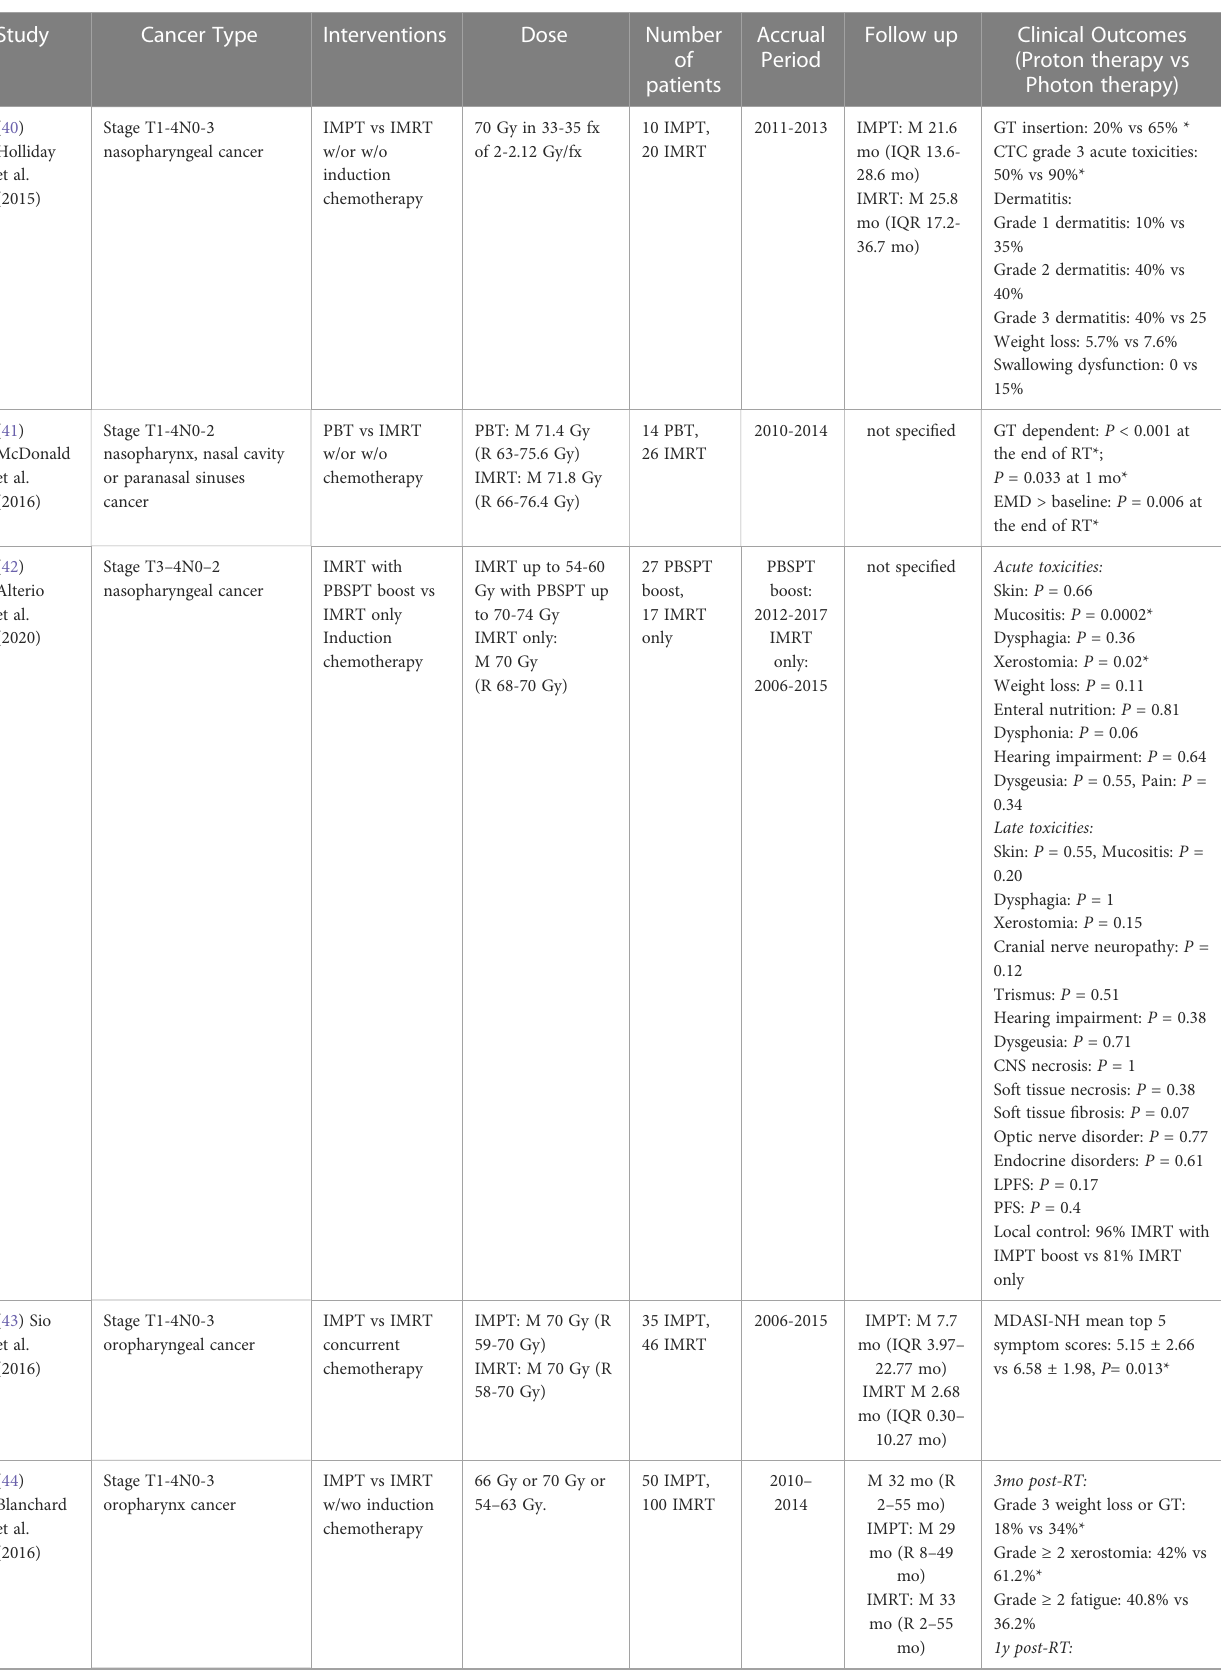
TABLE 5 Non-randomized clinical studies of proton versus photon radiation therapy – head and neck